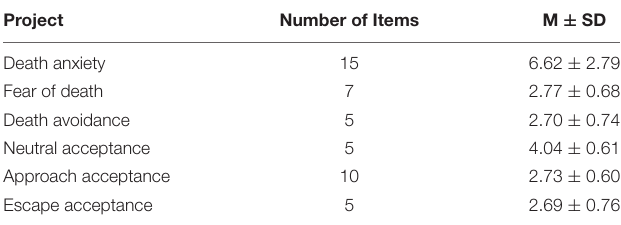
TABLE 1 | Results of the death attitudes and death anxiety survey ( n = 382).